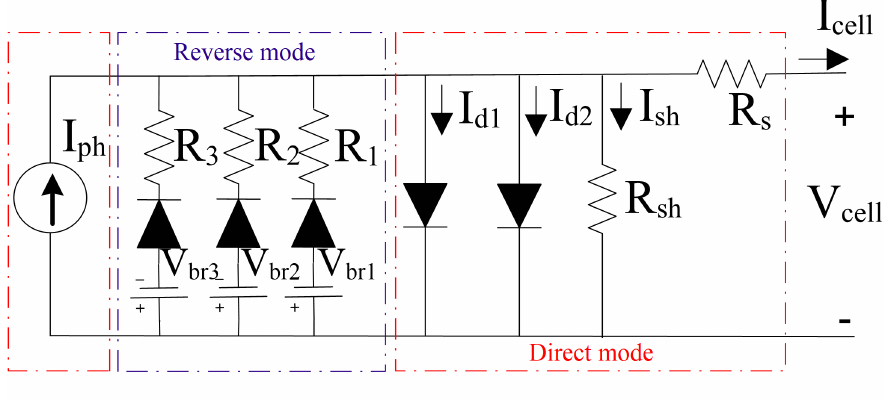
Figure 4. Circuit diagram of the Direct-Reverse